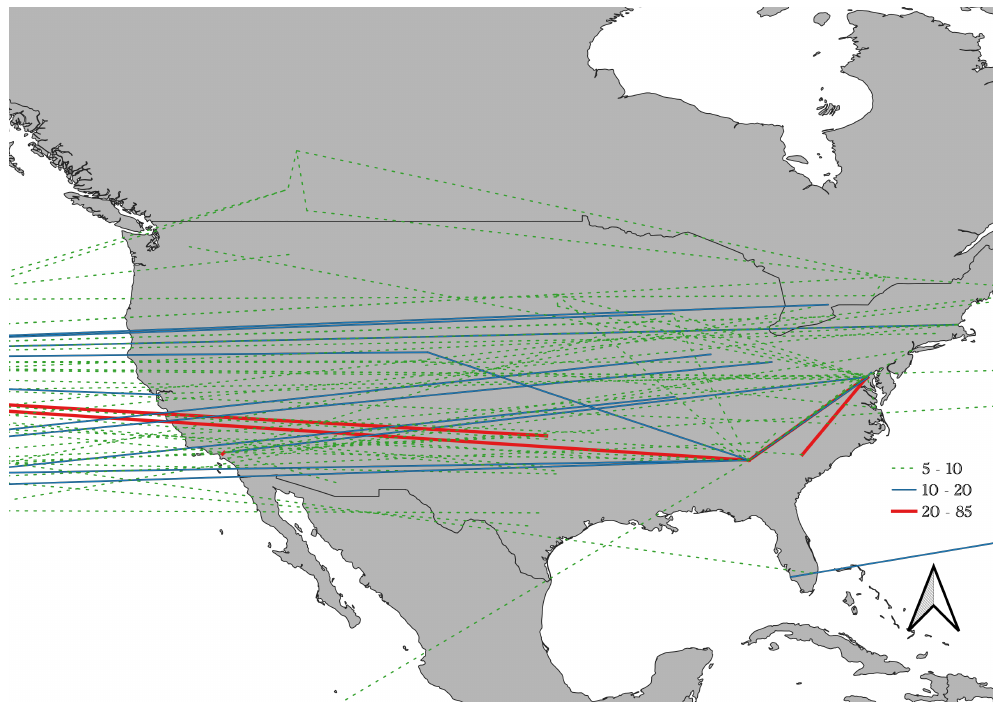
Figure 16. Connections of affiliations of articles published in Remote Sensing with an affiliation in the